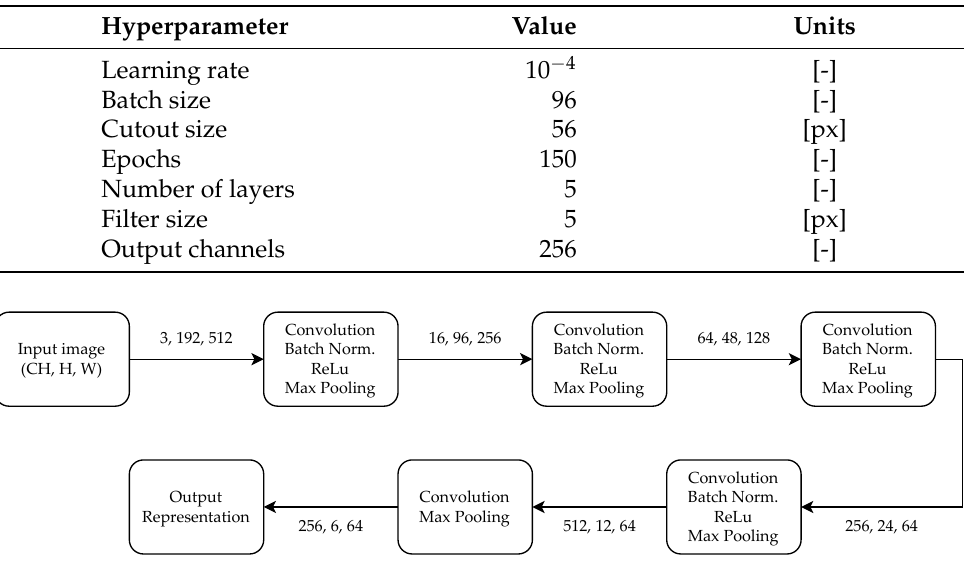
Figure 7. Visualization of backbone architecture and the dimensions of the tensors. It can be seen that at the end of the network is pooling used only for height to reduce the sensitivity to vertical shift between